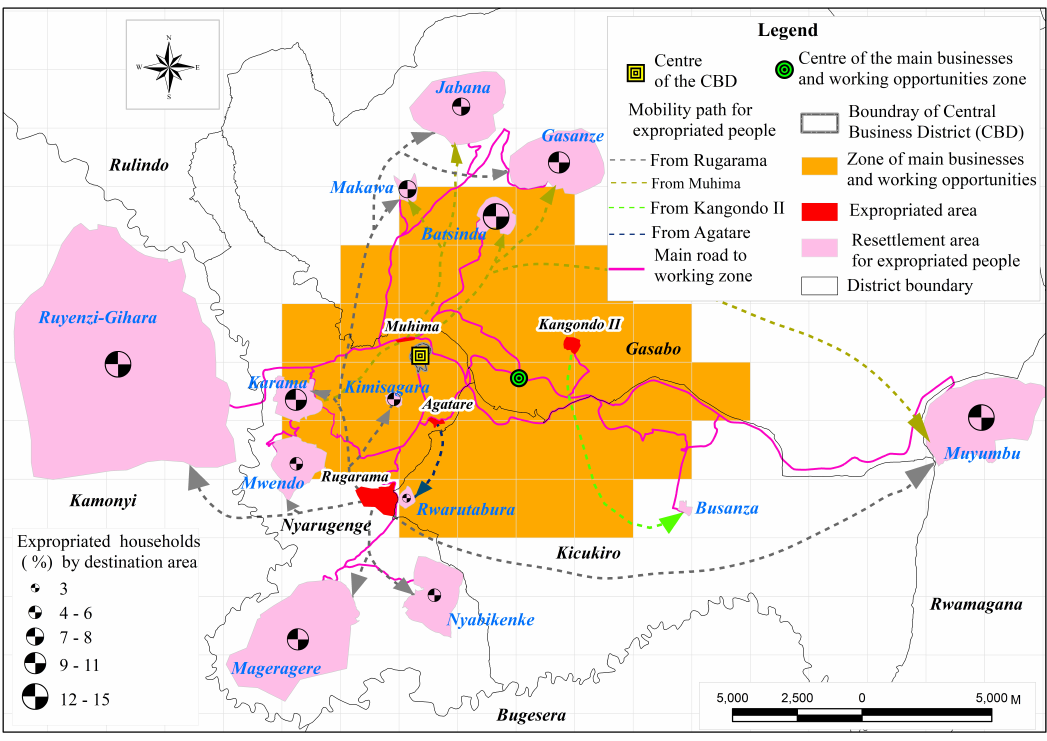
Figure 9. Resettlement sites for expropriated people and travel network to working places. Data Figure 9 . Resettlement sites for expropriated people and travel network to working places. Data Figure 7. Figure9.This is a figure, Schemes follow the same formatting. If there are multiple panels, source: Kigali city, Geo-datasets on services and business areas in Kigali city; NSIR and CGIS-UR [40]; source: Kigali city, Geo-datasets on services and business areas in Kigali city; NSIR and CGIS-UR[40]; they should be listed as: ( a ) Description of what is contained in the first panel. ( b ) Description of what Household surveys and field observations. Household surveys and field observations. is contained in the second panel. Figures should be placed in the main text near to the first time they are cited. A caption on a single line should be centered.